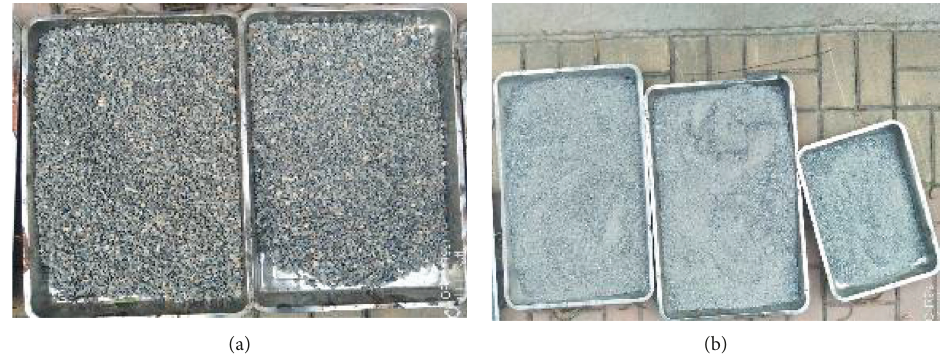
Figure 2: The basalt and limestone aggregates. (a) 5–10 mm basalt; (b) 0–3 mm limestone.